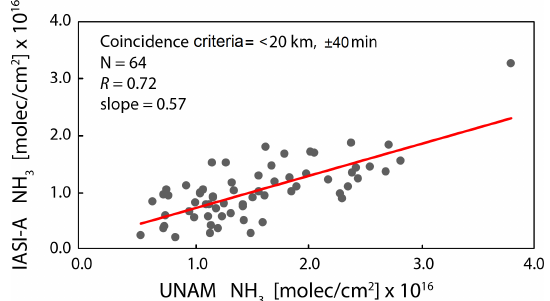
Figure 6. Correlation plot for IASI-A NH 3 vs. UNAM FTIR-NH 3 total columns, with coincidence criteria of < 20km, ± 40min, el- evation (FTIR station – IASI observation) < 300m, IASI-NH 3 re- trieval error < 100% between November 2013 and December